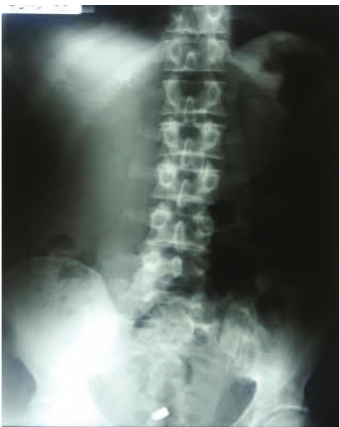
Figure 1: Erect abdominal radiograph shows the bullet in the lower abdomen.